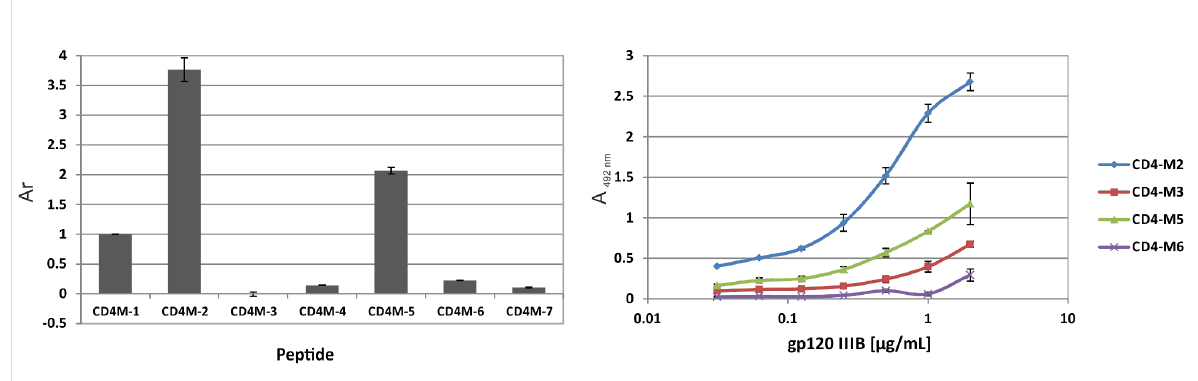
Figure 3: Left: Relative affinities ( A r , CD4-M1 = 1) to gp120(IIIB) of peptides. Right: Concentration-dependent binding of gp120 to peptides. Absorbance values (A) are corrected for the respective blanks (wells without peptide). See Table 1 for peptide sequences and Experimental section for details of the binding